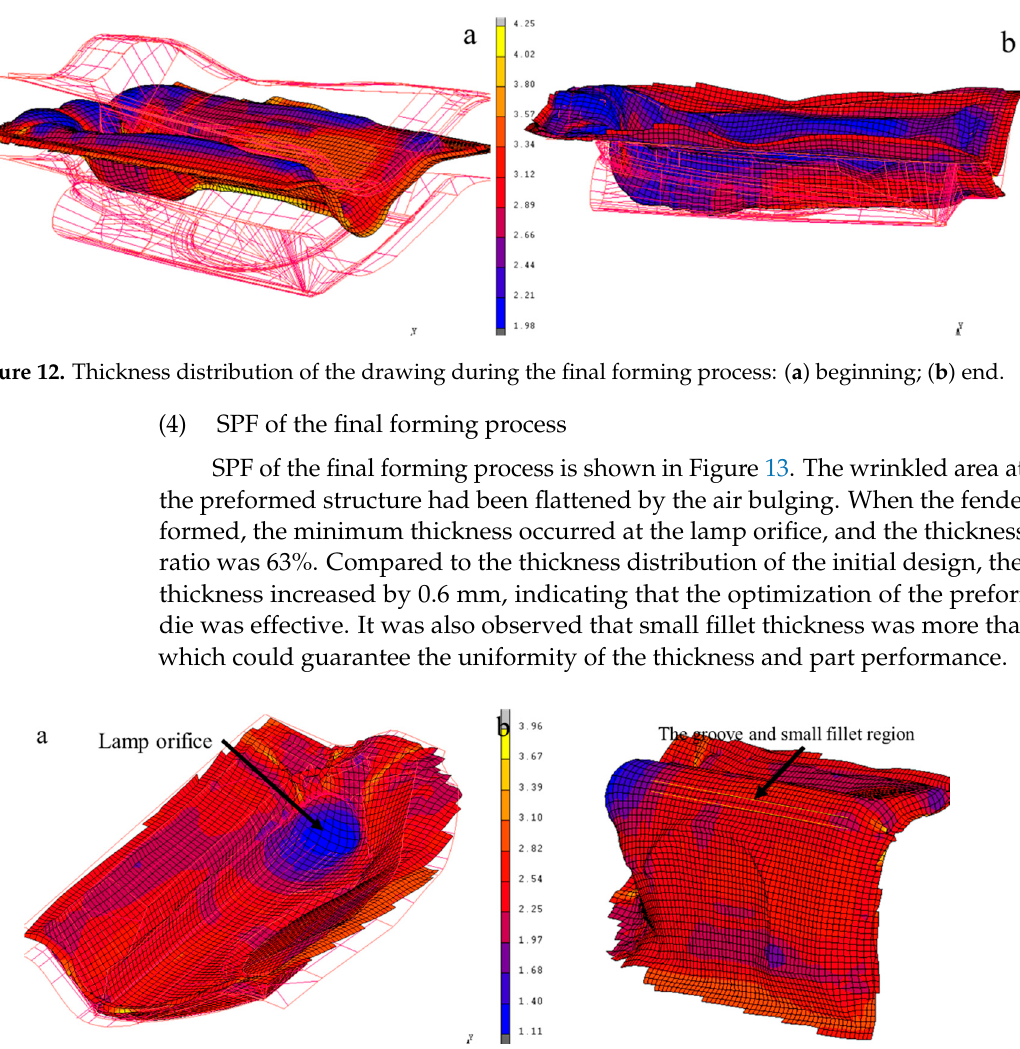
9 of 15 Figure 11. Thickness distribution of reverse bulging during the preforming process. (3) Drawing of the final forming process